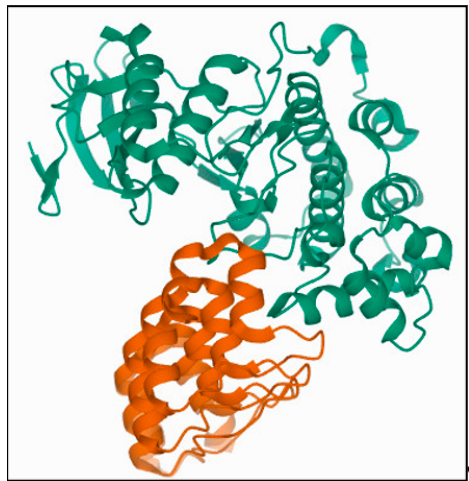
Figure 8 . Biological assembly of E40/ERK2 (PDB ID:3ZU7). Ribbon diagrams of DARPin and ERK2 are shown in orange and green, respectively.